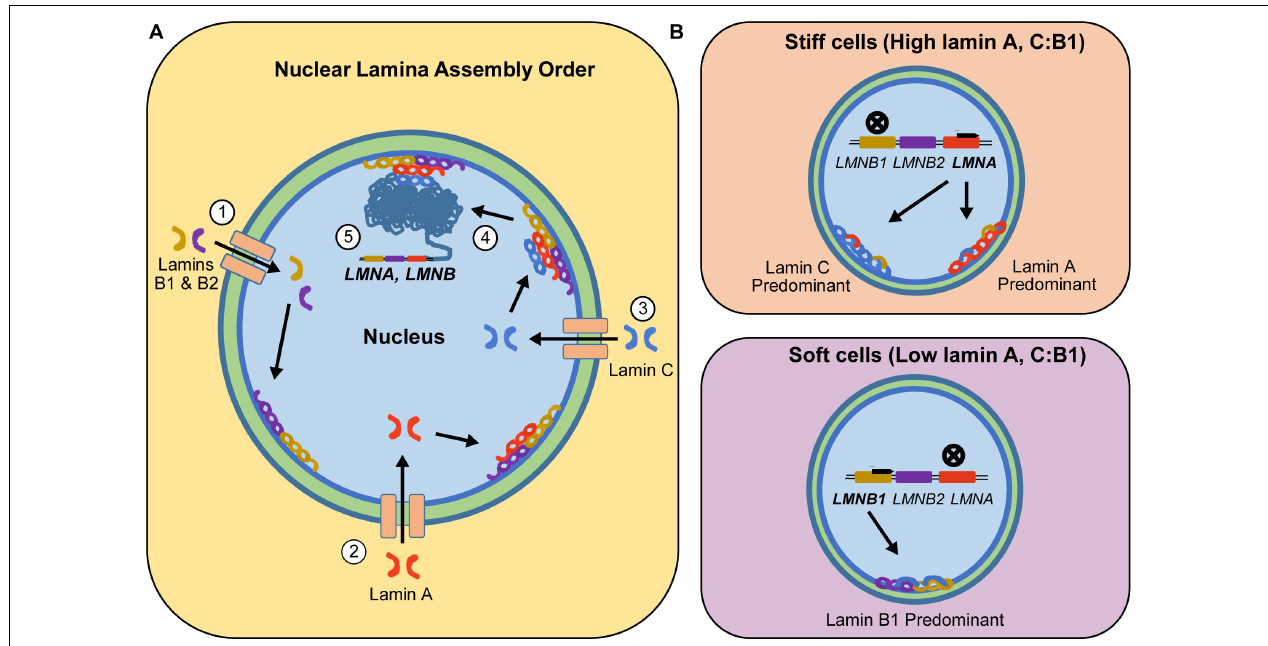
FIGURE 1 | Step-wise incorporation of lamin isoforms into the nuclear lamina and resulting isoform expression based on cells’ inherent mechanophenotype. (A) B-type lamins enter the nucleus and form the first layer of the nuclear lamina (Step 1). The incorporation of B-type lamins into the nuclear lamina allows them to recruit internalized lamin A isoforms into the nuclear lamina (Step 2). Once lamin A is part of the nuclear lamina, internalized lamin C proteins can attach to the nuclear lamina meshwork (Step 3). All these recruited lamin proteins generate intracellular tension that is relayed into the chromatin network (Step 4), which in part regulates expression of lamins to match the characteristic levels of a given mechanophenotype (Step 5). (B) This intracellular tension-led regulation will upregulate LMNA genes in stiff cells, resulting in cells expressing higher levels of lamin A or C. However, in soft cells, intracellular tension is low, resulting in downregulation of LMNA and upregulation of LMNB1. During these processes, lamin isoforms assemble as homodimers and inter-lamin interactions with the nuclear lamina are facilitated by lamin-binding and other accessory